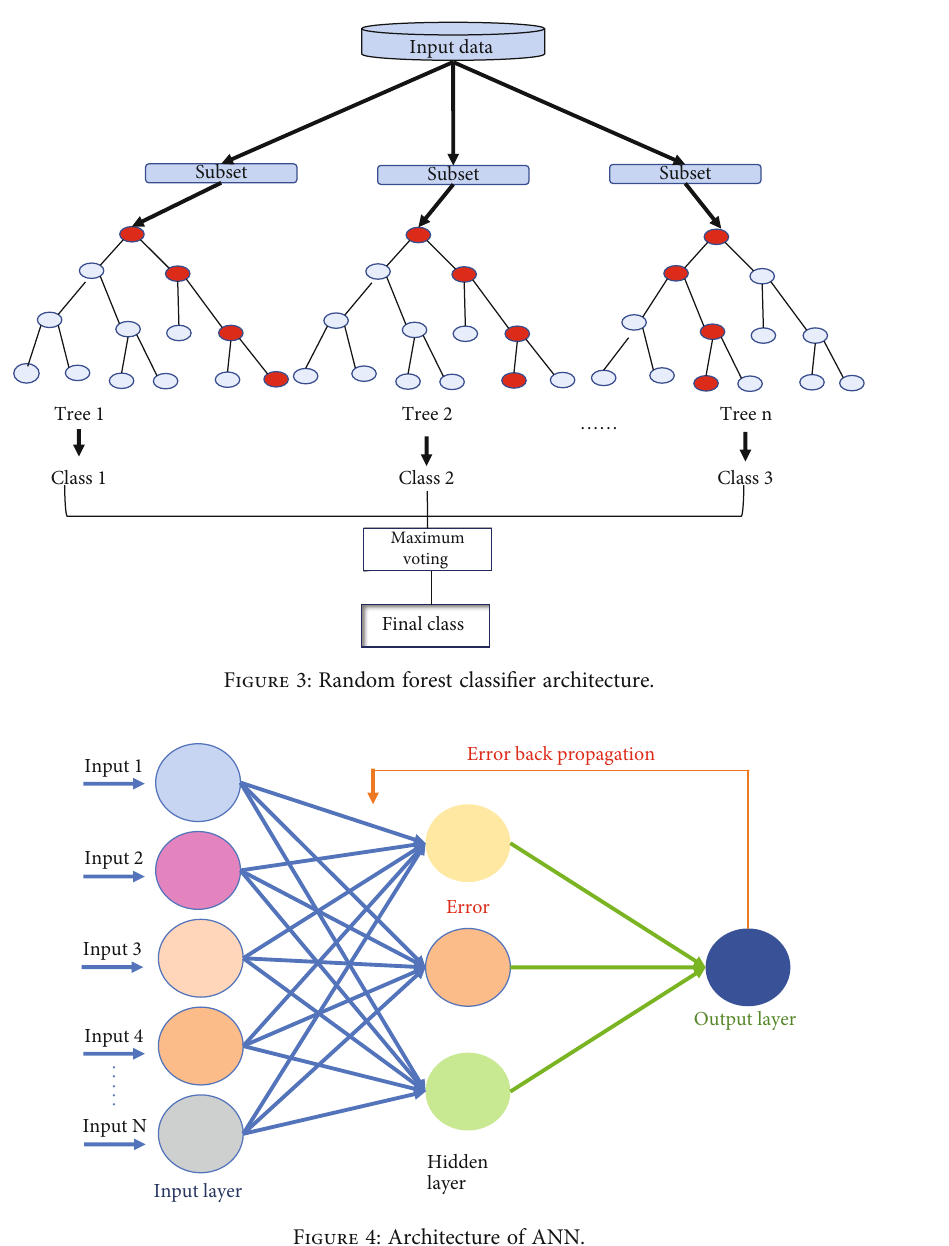
Figure 4: Architecture of